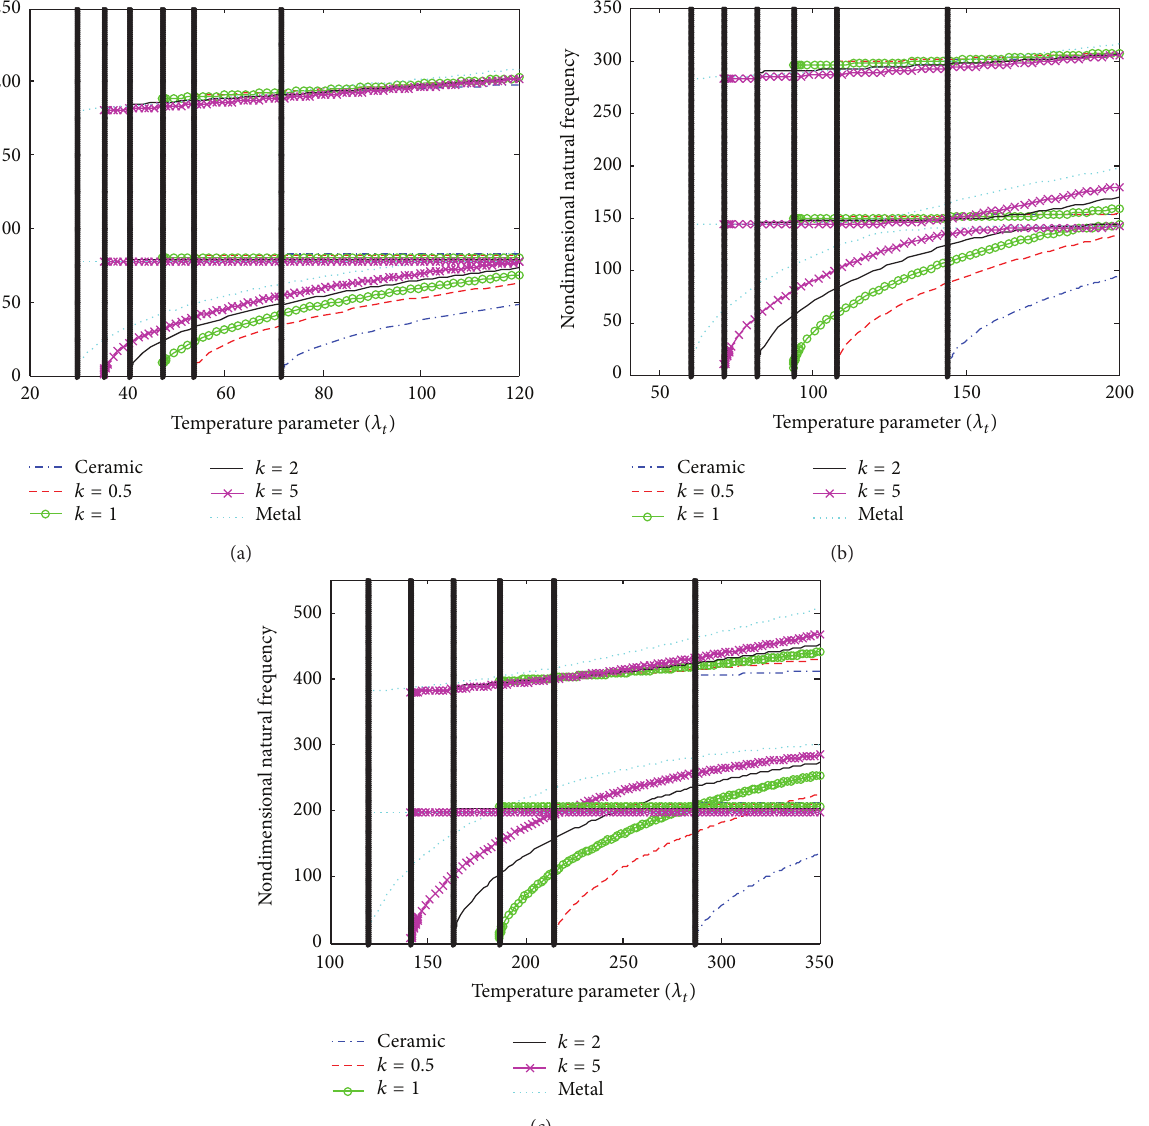
Figure 8: Variation of the nondimensional natural frequency of vibration around the (a) first, (b) second, (c) third buckling mode with the temperature parameter for a clamped-clamped FG beam with different values of 𝑘 ( 𝑙/ℎ = 1 , 𝐿/ℎ = 40 ).